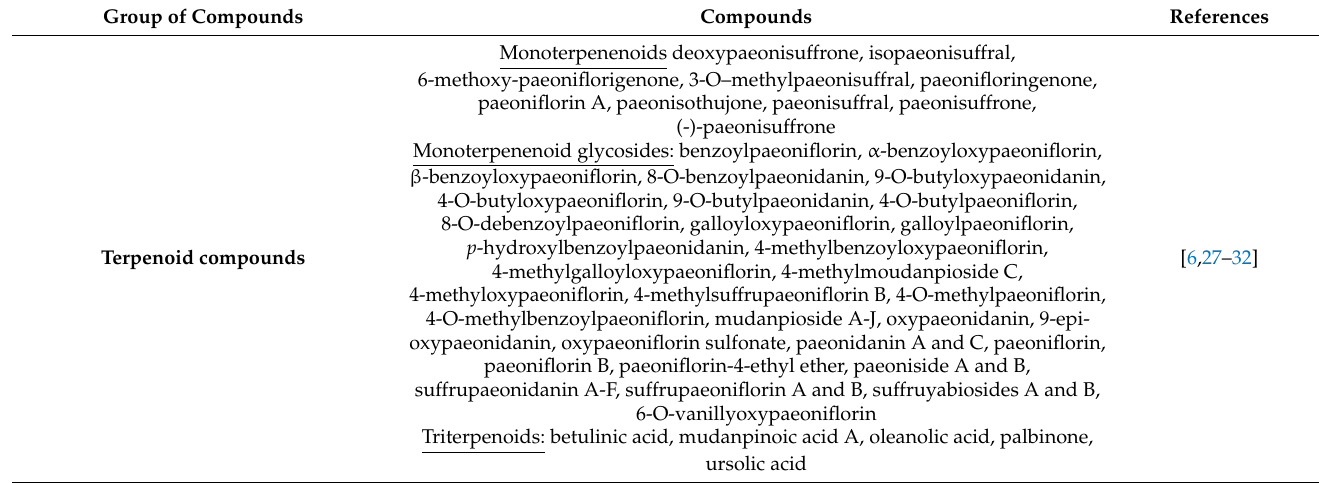
Figure 4. Chemical structure of 1,2,3,4,6-penta-O-galloilo- β -D- glucopyranose. Table 1. The most important chemical ingredients of Paeonia × suffruticosa . Group of Compounds